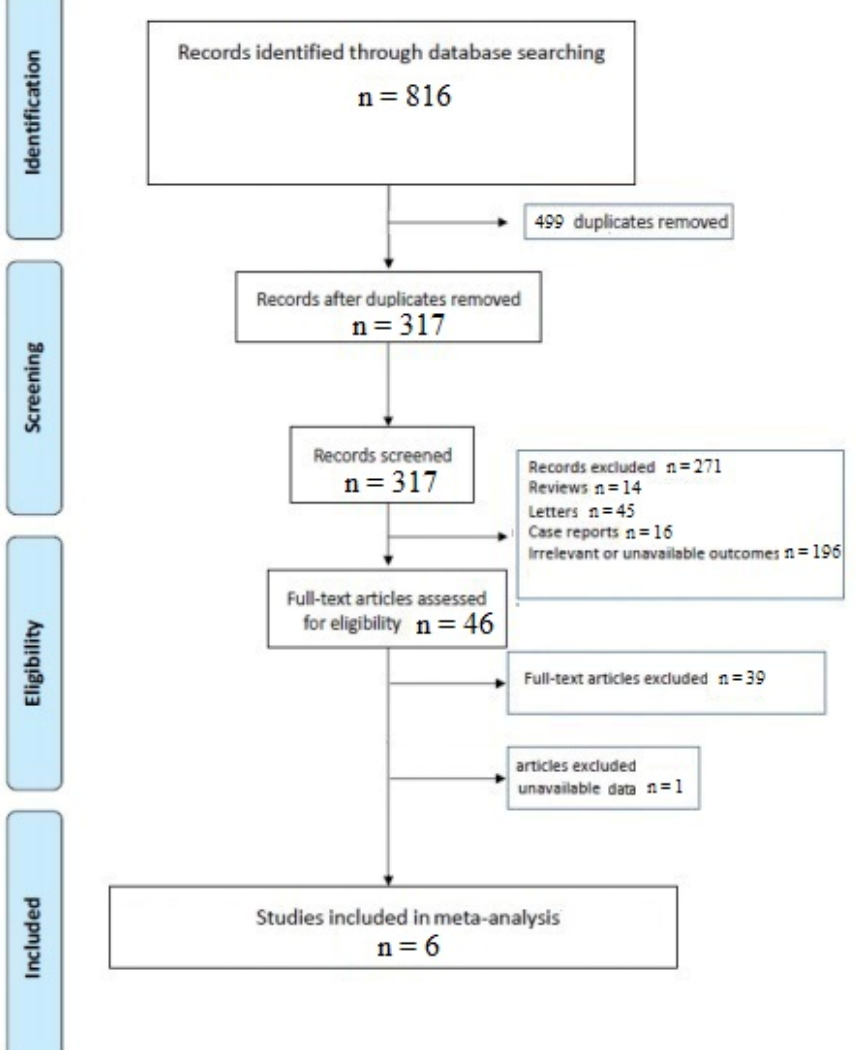
Figure 1. PRISMA flow